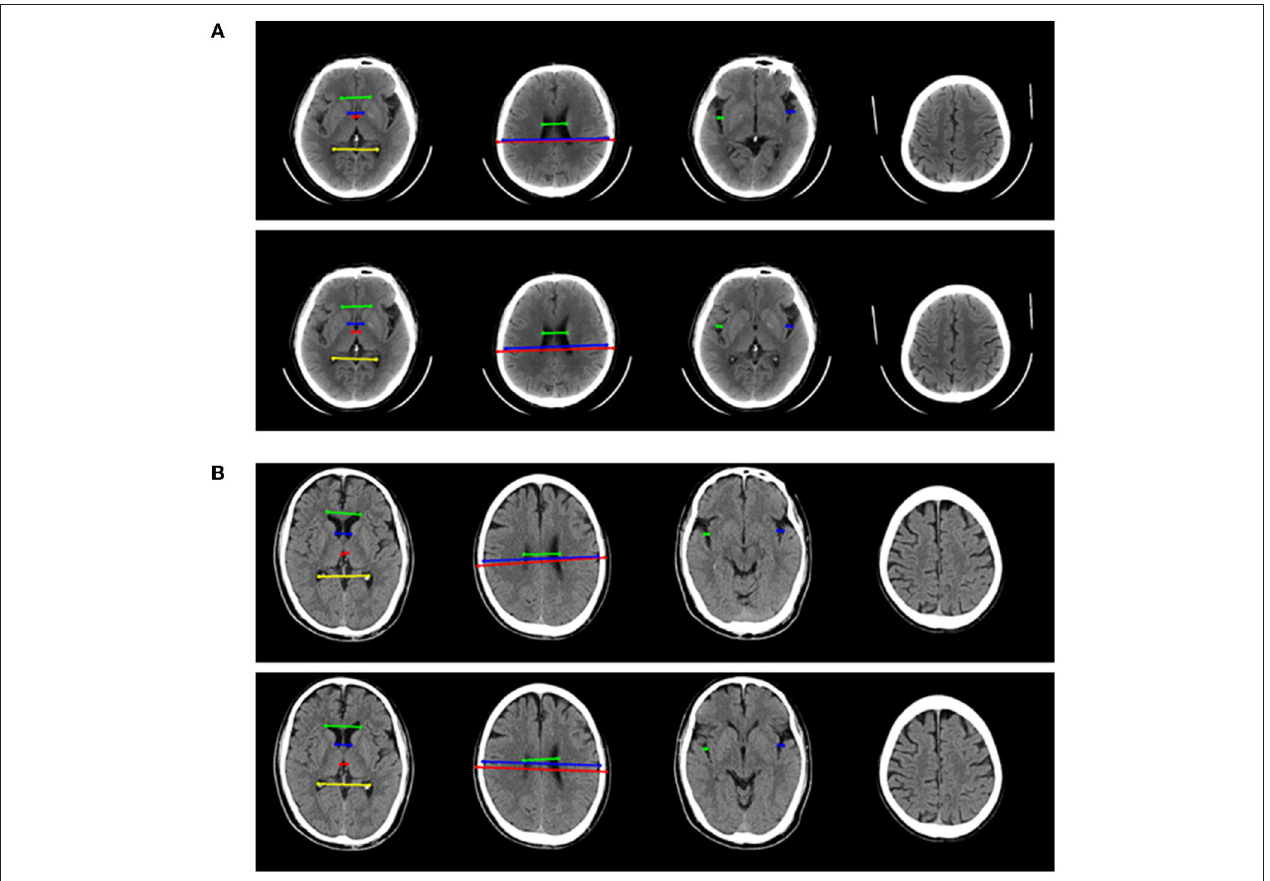
FIGURE 5 | Two representative examples of atrophy cases, which were misclassified. For each example, four key slices were presented from manual annotation (top) and detection of 2D model (bottom). On key slice 1, the green line represented A, the blue line represented B, the red line represented C and the yellow line represented D; On key slice 2, the green line represented E, the blue line represented F and the red line represented G; On key slice 3 ( * in Figures 5A,B ), the green line represented HL (long arrows), while the blue line represented HR (long arrows). (A) Example case was misclassified by 2D model but was correctly predicted by 3D model, 2D-integrated model, and 3D-integrated model. (B) . Example case was misclassified by both 2D model and 3D model but was correctly predicted by 2D-integrated model and 3D-integrated model.